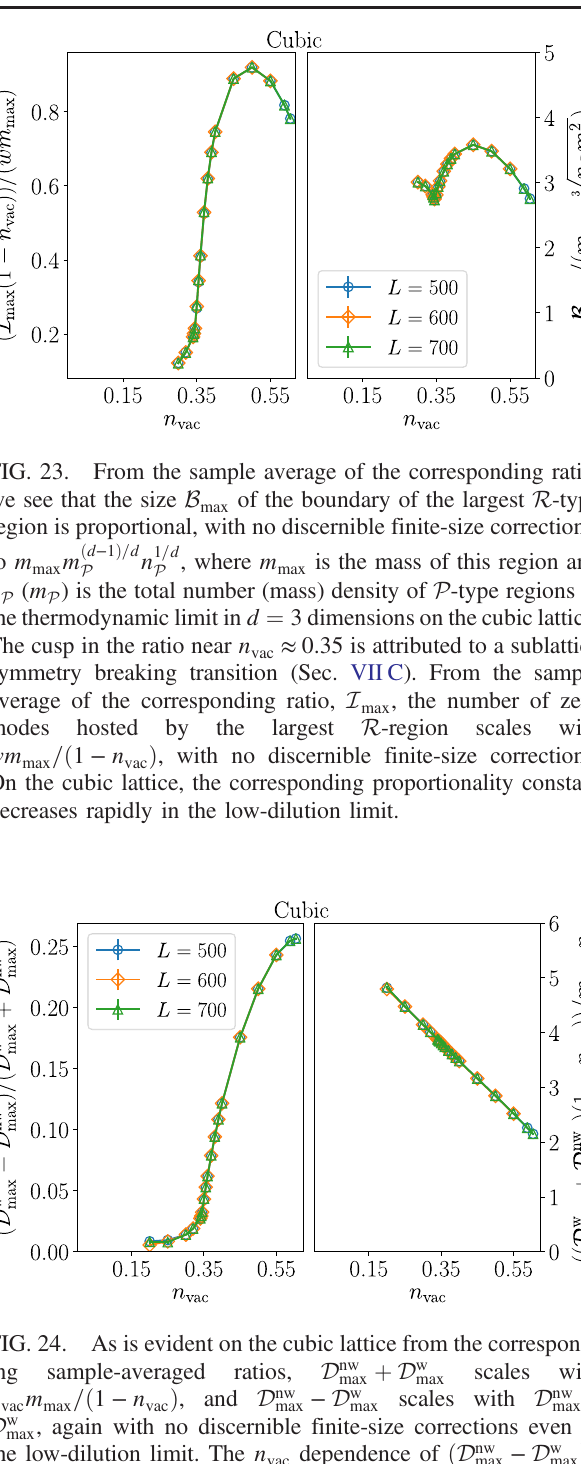
FIG. 24. As is evident on the cubic lattice from the correspond- þ D w ing sample-averaged ratios, D nw scales with max max n m = ð 1 − n Þ , and D nw − D w þ scales with D nw vac max vac max max max D w , again with no discernible finite-size corrections even in max − D w Þ = the low-dilution limit. The n dependence of ð D nw vac max max ð D nw þ D w Þ broadly resembles that of I ð 1 − n Þ =wm max max max vac max in the low-dilution limit.